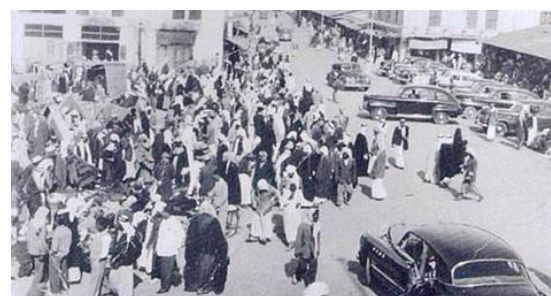
Figure 14: Vegetable Market in Manama 1930s-ish; Droodkin,